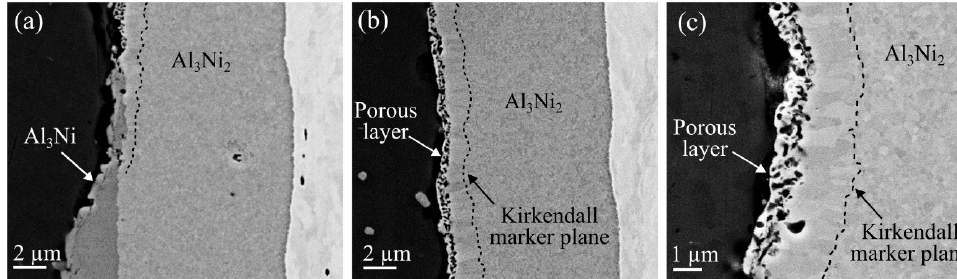
Figure 8. SEM images of the cross-section of a composite heat treated at 550 °C for two hours. ( a ) shows an area where the IMP layer goes from consisting of both Al 3 Ni and Al 3 Ni 2 , to only Al 3 Ni 2 . ( b , c ) shows morphology inside the Al 3 Ni 2 layer (the Kirkendall marker plane) is highlighted by dashed lines. A porous structure in the Al 3 Ni 2 along the interface towards aluminum can be observed.